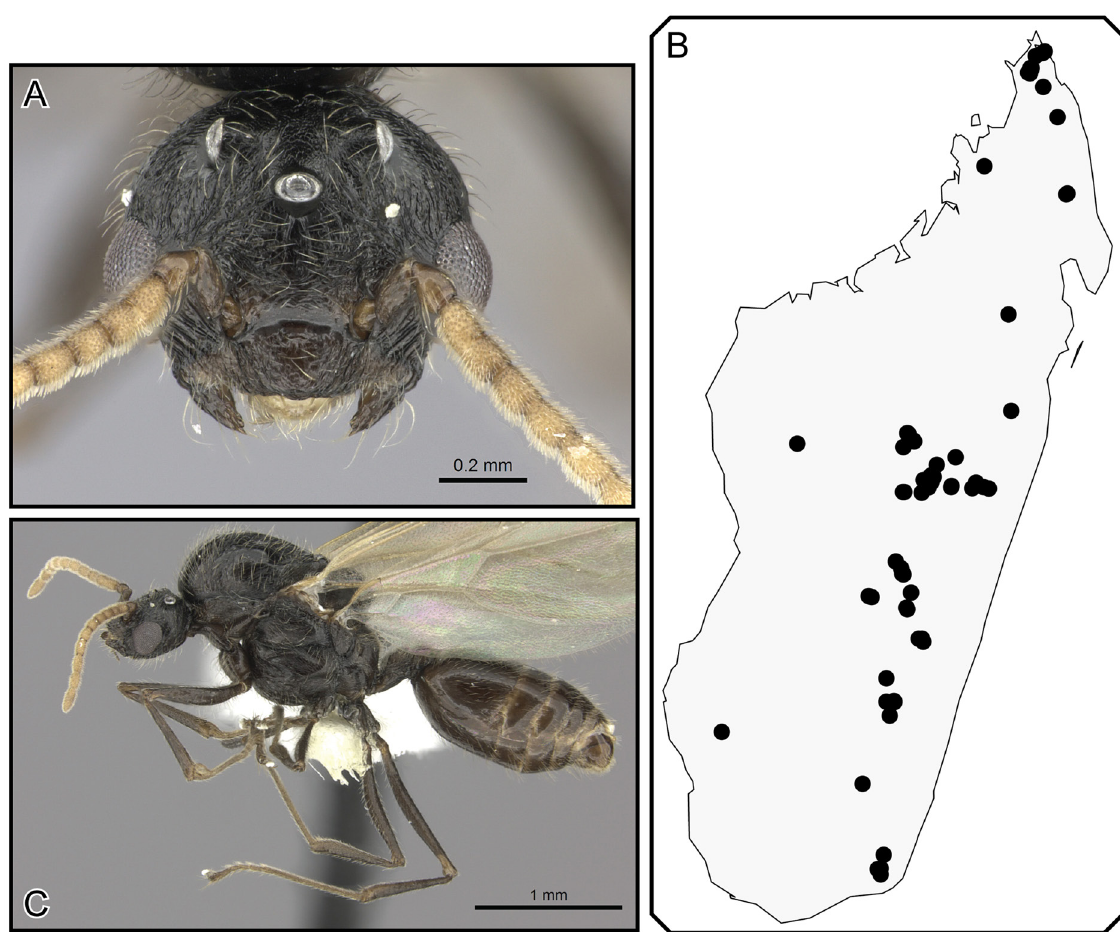
Fig. 14. Crematogaster mafybe sp. nov., male and distribution. A, C. Male (CASENT0193465). A. Full- face. C. Profile. B. Species